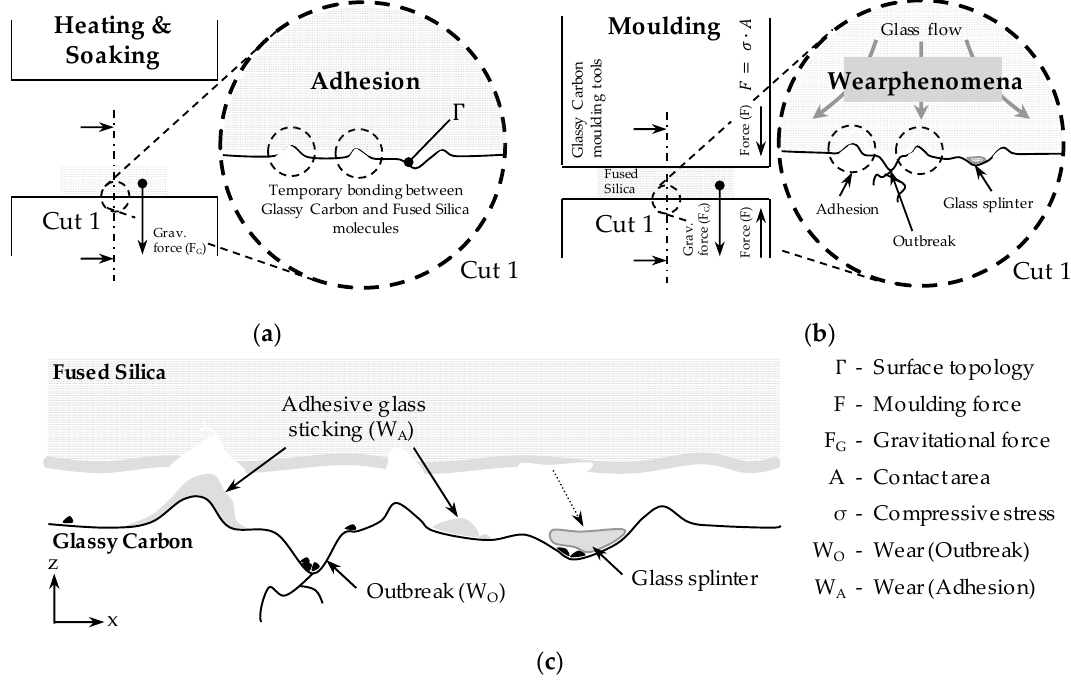
Figure 21. Extended wear evolution model of Fused Silica moulding with Glassy Carbon moulding tools (based on [27]): ( a ) Temporary bonding between the contact partners; ( b ) Conditions during moulding phase; ( c ) Wear result after moulding and detachment of the moulded glass component.